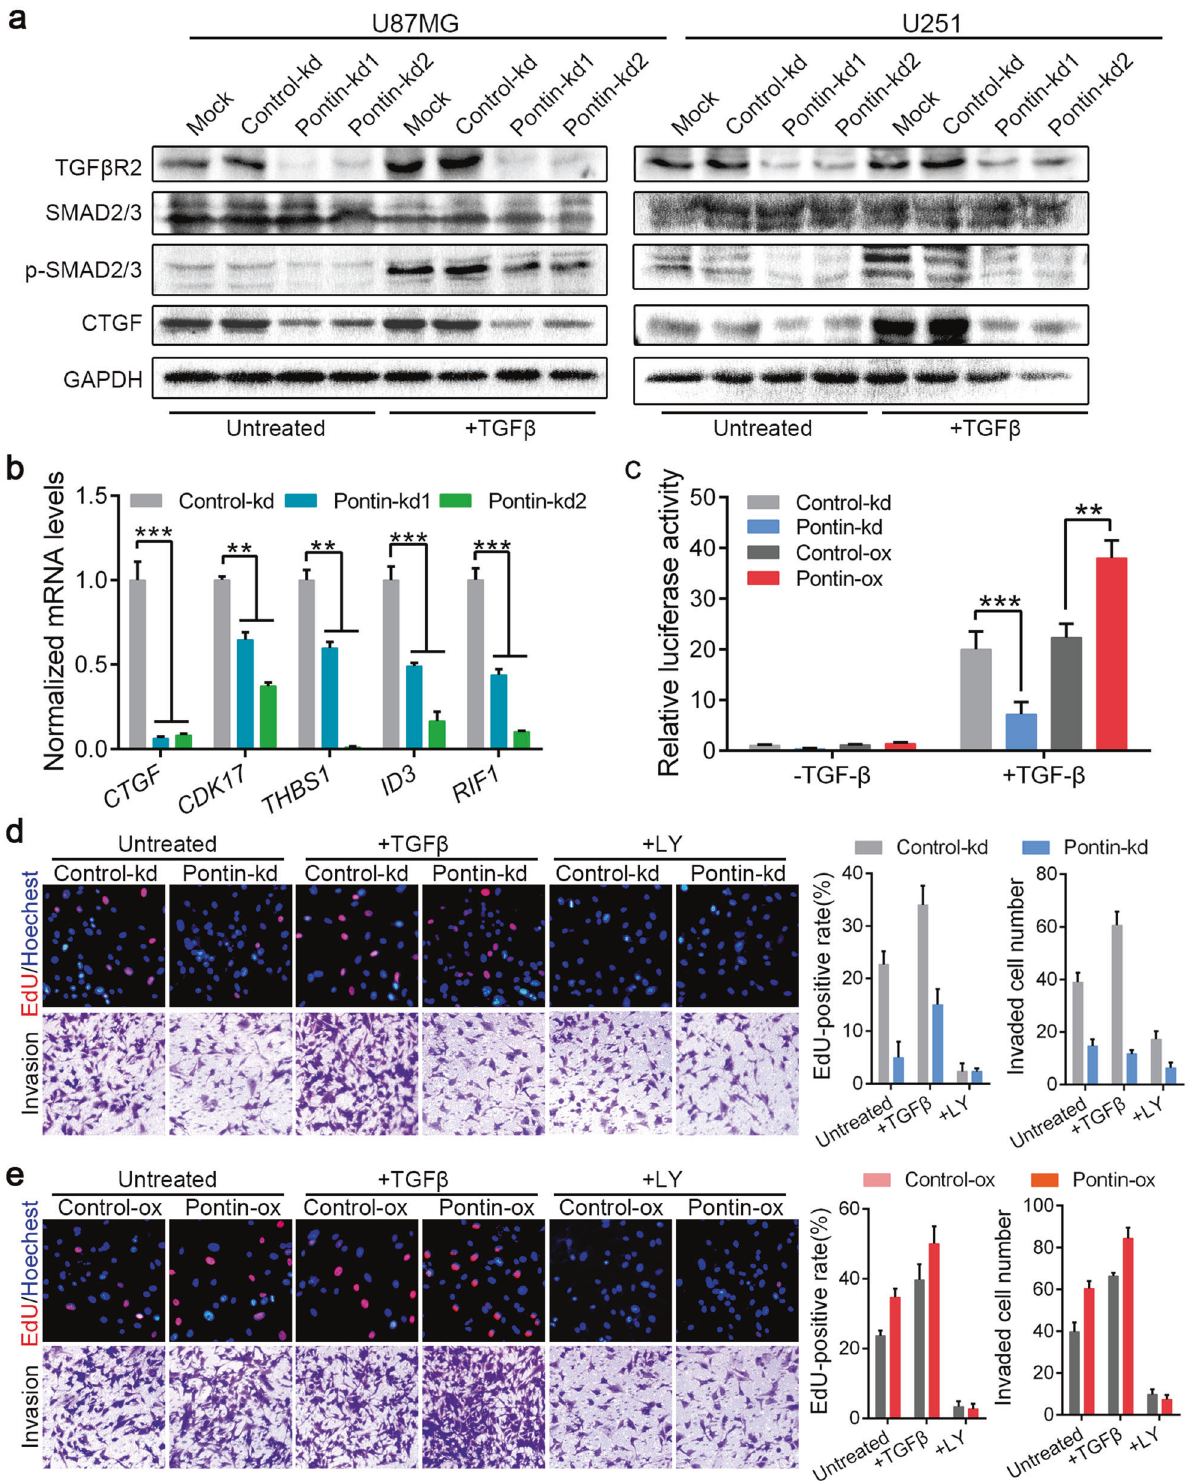
Fig. 5 Pontin is required for TGF β /SMAD signalling and critical for TGF β -induced cell proliferation and invasion. a Western blot analyses of TGF β R2, p-SMAD2/3, SMAD2/3 and CTGF in the established Pontin-silenced U87MG and U251 cells without or with TGF β (5 ng/ml) treatment overnight. Loading control: GAPDH. b qRT-PCR detection of TGF β /SMAD target gene expression in the established Pontin-silenced U87MG cells. c Effect of Pontin knockdown or overexpression on the CAGA12-Luc transcriptional response induced by TGF β (5 ng/ml) in U87MG cells. d Effect of Pontin knockdown on TGF β - or LY-induced cell proliferation and invasion assessed by EdU staining and transwell invasion assays, respectively. Representative images (left) and the comparison results (right) were shown. e Effect of Pontin overexpression on TGF β - or LY-induced cell proliferation and invasion assessed by EdU staining and transwell invasion assays, respectively. Representative images (left) and the comparison results (right) were shown. Data in b – e are expressed as means ± SDs, n = 3. ** P < 0.01, *** P < 0.001 by one-way ANOVA (Dunnett ’ s post test).